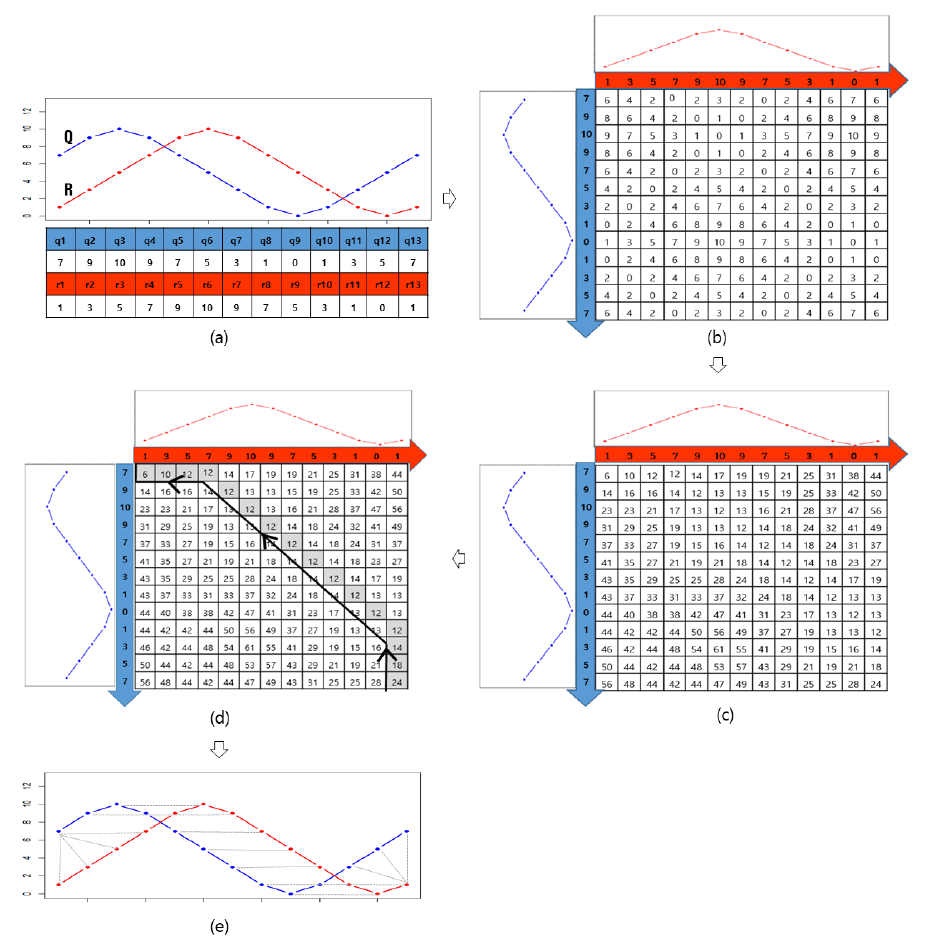
Figure 4. Illustration of global cost matrix and warping path of the classic Dynamic Time Warping (DTW) algorithm; ( a ). Two time series ( b ). Local cost matrix ( c ). Global cost matrix ( d ). Optimal warping path ( e ). DTW alignment.